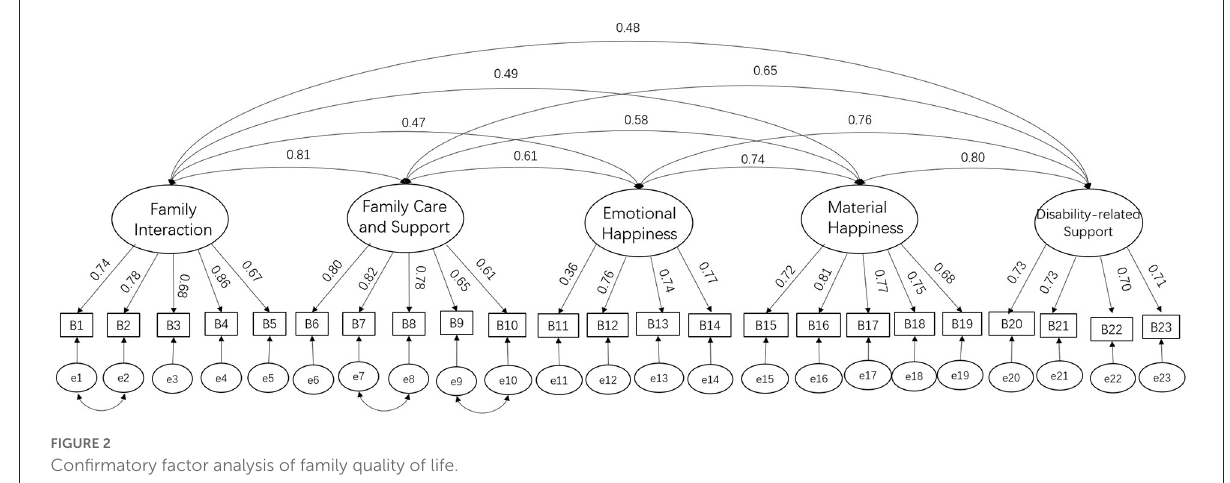
FIGURE2 Confirmatory factor analysis of family quality of